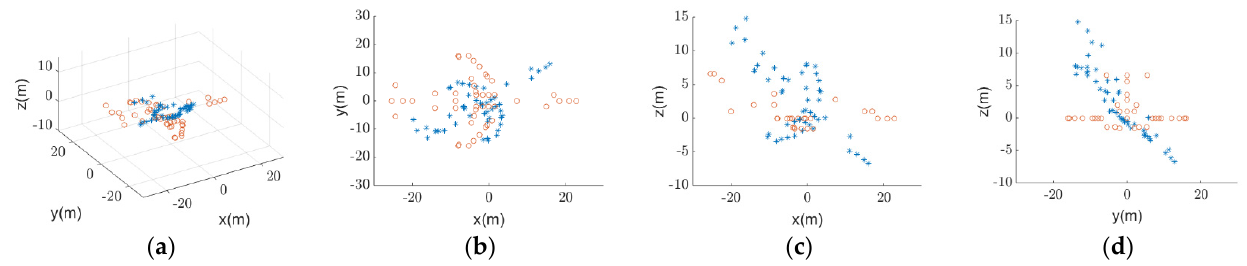
Figure 8. 3D imaging results by the traditional method without removing the squint effect, in ( a ) 3D; ( b ) projection on x-y plane; ( c ) projection on x-z plane; ( d ) projection on y-z plane.